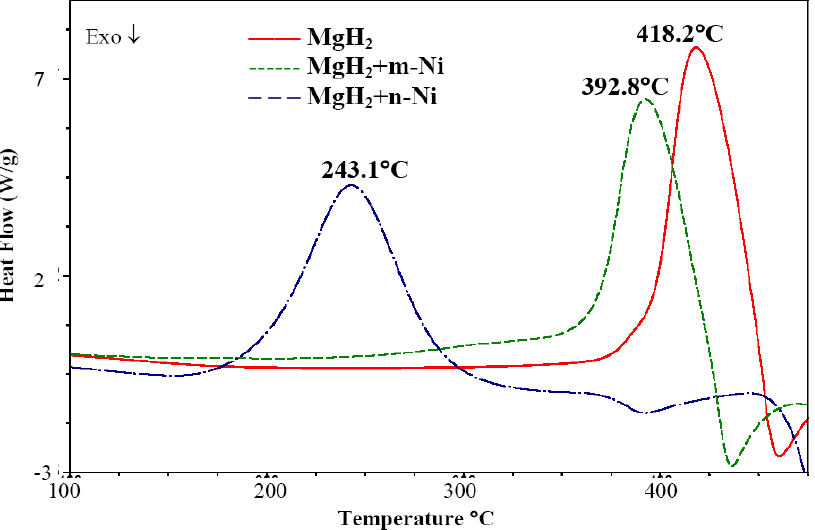
Figure 7. DSC traces of MgH doped with 5 wt.% Vale Inco Ltd. micrometric Ni 2 (m-Ni; SSA = 0.7 m 2 /g) and nanometric Ni (n-Ni; SSA = 14.5 m 2 /g) subjected to 15 min of ball milling under 700 kPa hydrogen pressure. Heating rate 10 °C/min. Adapted from